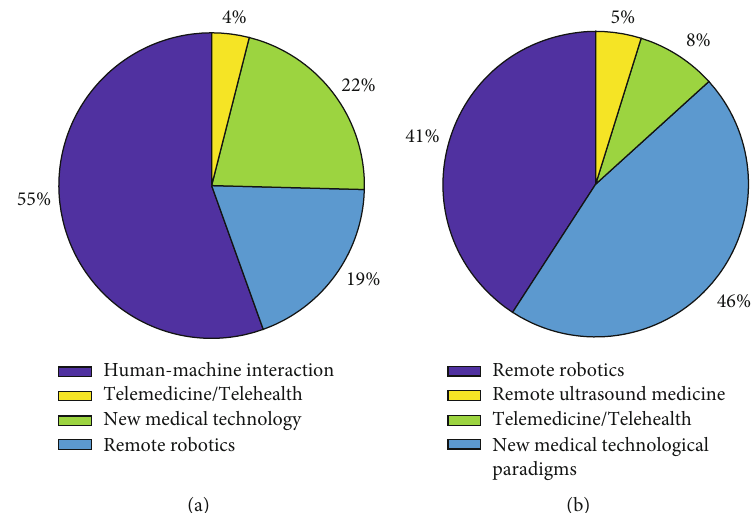
Figure 1: (a) Google results obtained for metatechnological areas. (b) Google results for metatechnological areas related to